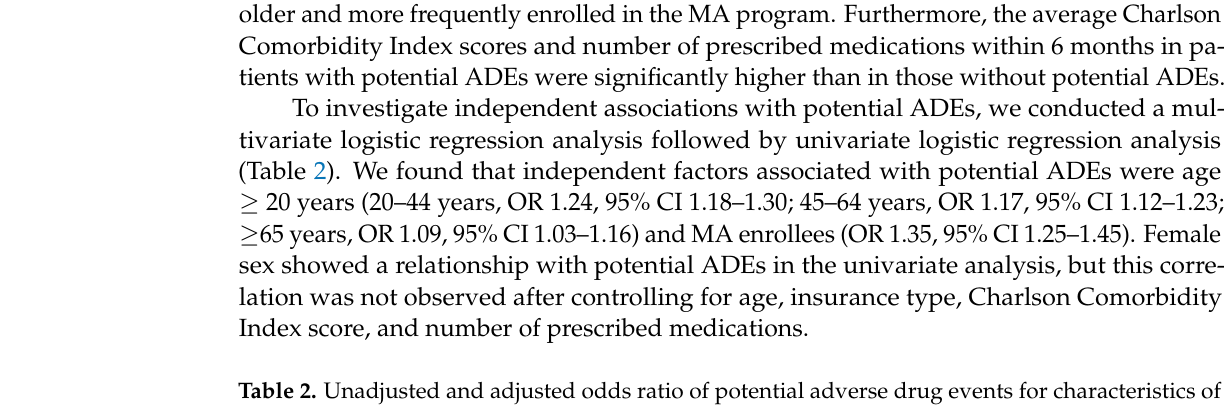
Table 2. Unadjusted and adjusted odds ratio of potential adverse drug events for characteristics of the study